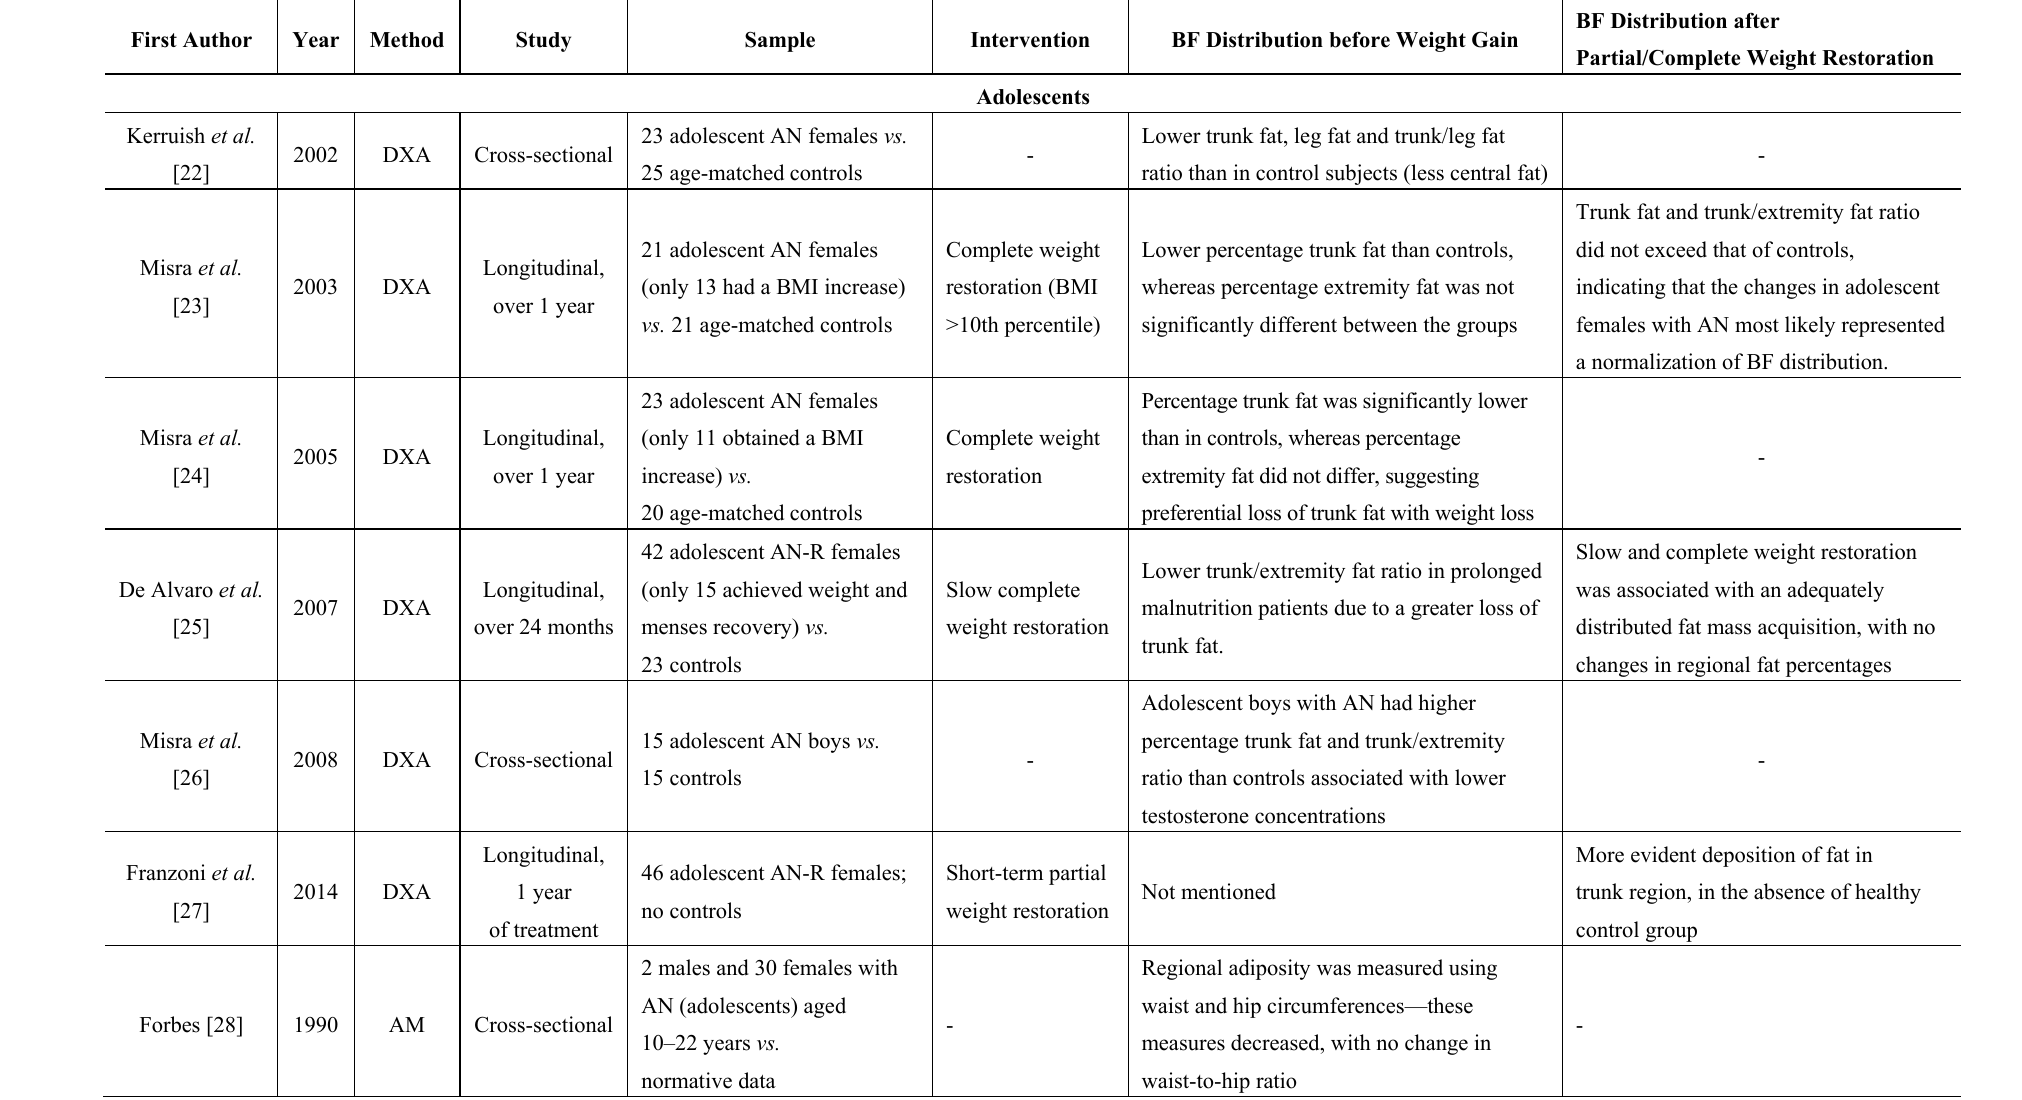
Table 1. Studies included in the systematic